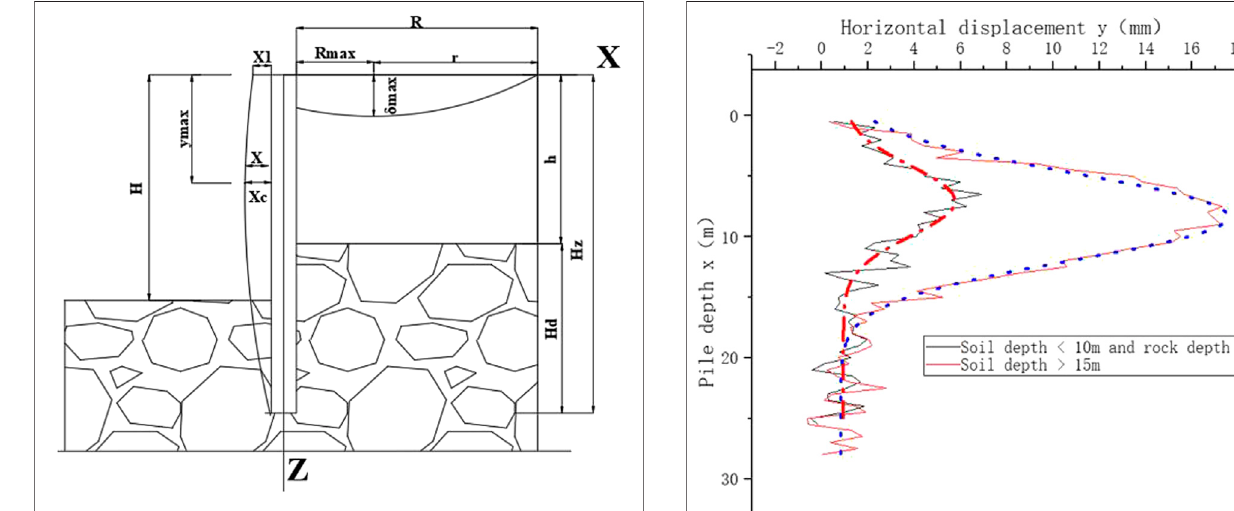
FIGURE 3 | Calculation diagram of surface settlement and horizontal displacement.